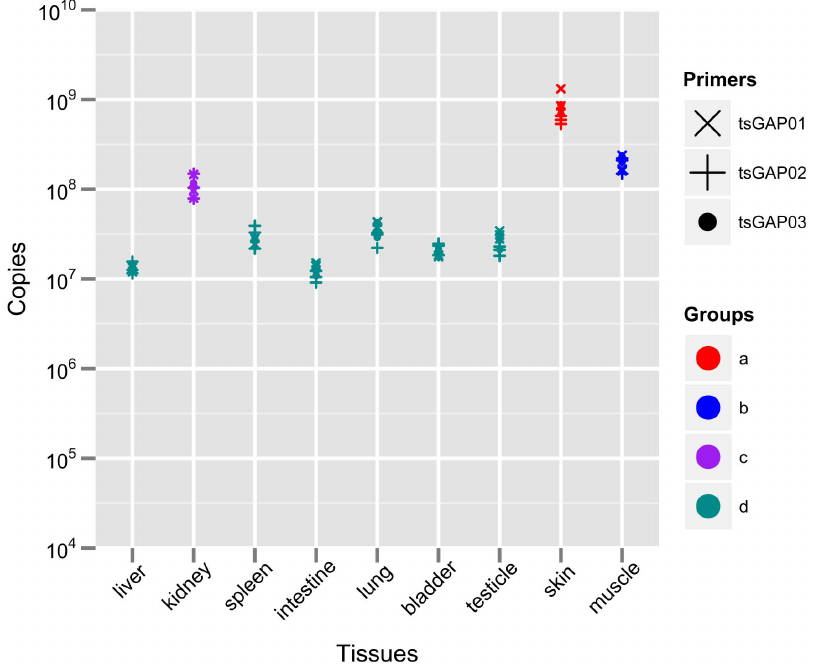
Figure 3. Expression-Profile Measurement of Tree shrew GAPDH Gene. Three pair of primers for qRT-PCR were designed to measure tsGAPDH mRNA expression in various tree shrew tissues. Data are shown in a point chart and grouped according to ANOVA (p , 0.05).